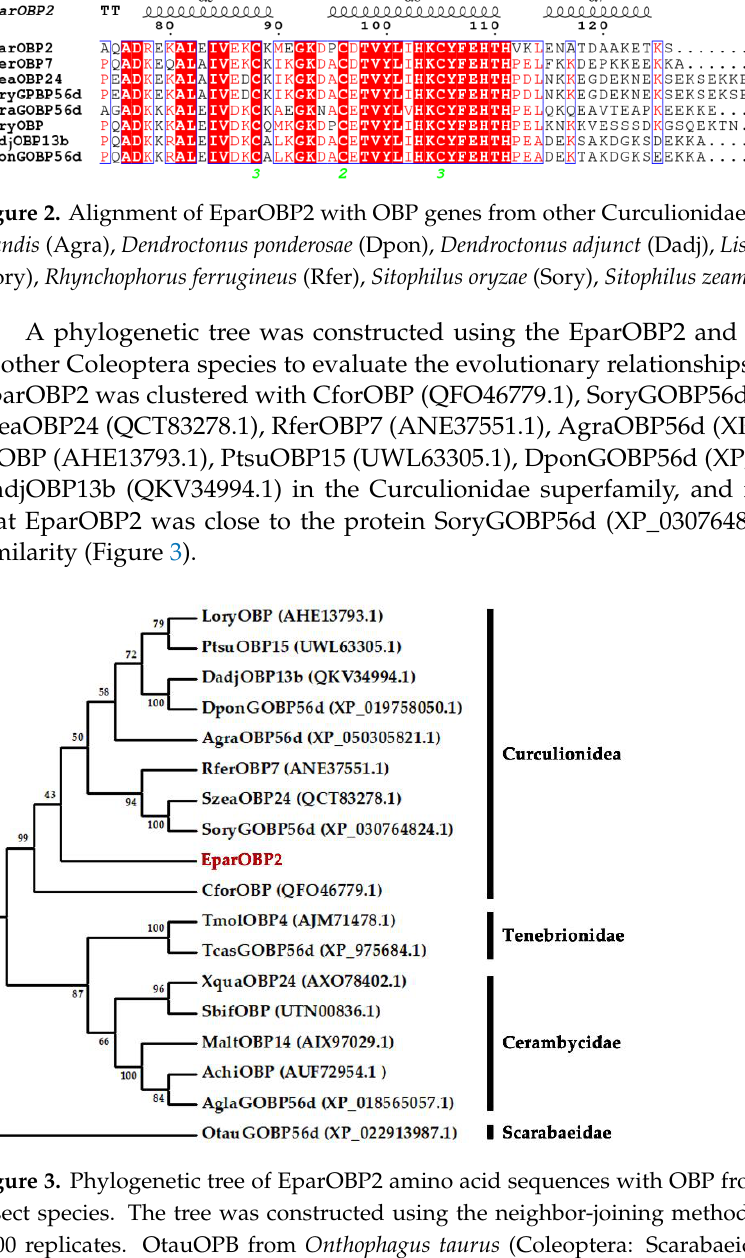
Figure 2. Alignment of EparOBP2 with OBP genes from other Curculionidae insects . Anthonomus grandis (Agra), Dendroctonus ponderosae (Dpon), Dendroctonus adjunct (Dadj), Lissorhoptrus oryzophi- lus (Lory), Rhynchophorus ferrugineus (Rfer), Sitophilus oryzae (Sory), Sitophilus zeamais (Szea) .